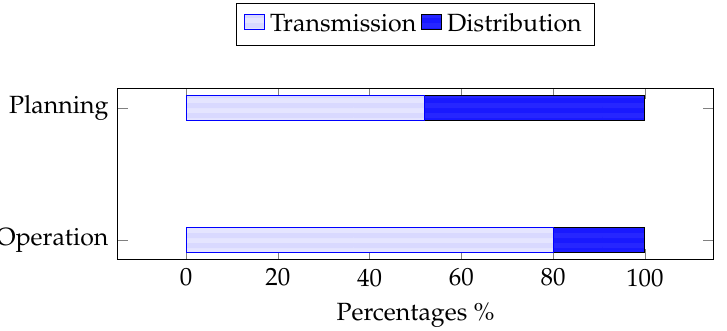
Figure 2. Investment and operational phases represented in the ESS models.